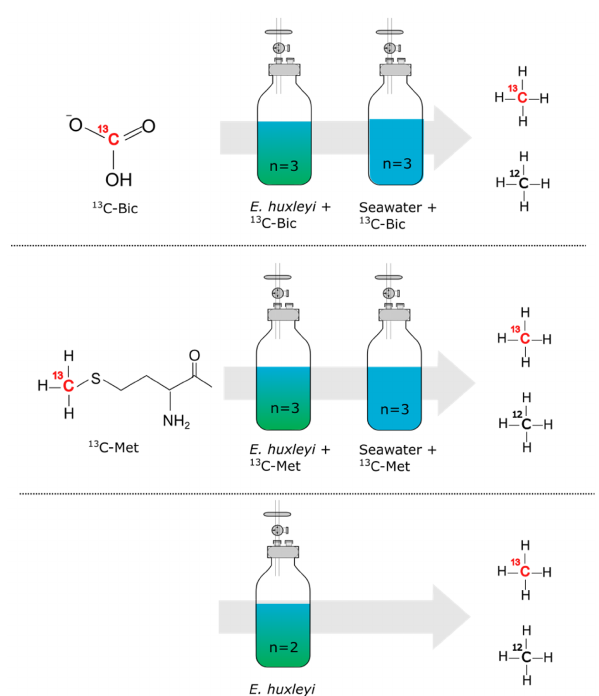
Figure 1. Experimental setup: the potential precursors of CH 4 , 13 C- labeled bicarbonate ( 13 C-Bic) or a position-specific 13 C-labeled methionine ( 13 C-Met) were added to the flasks containing either a culture of E. huxleyi or seawater